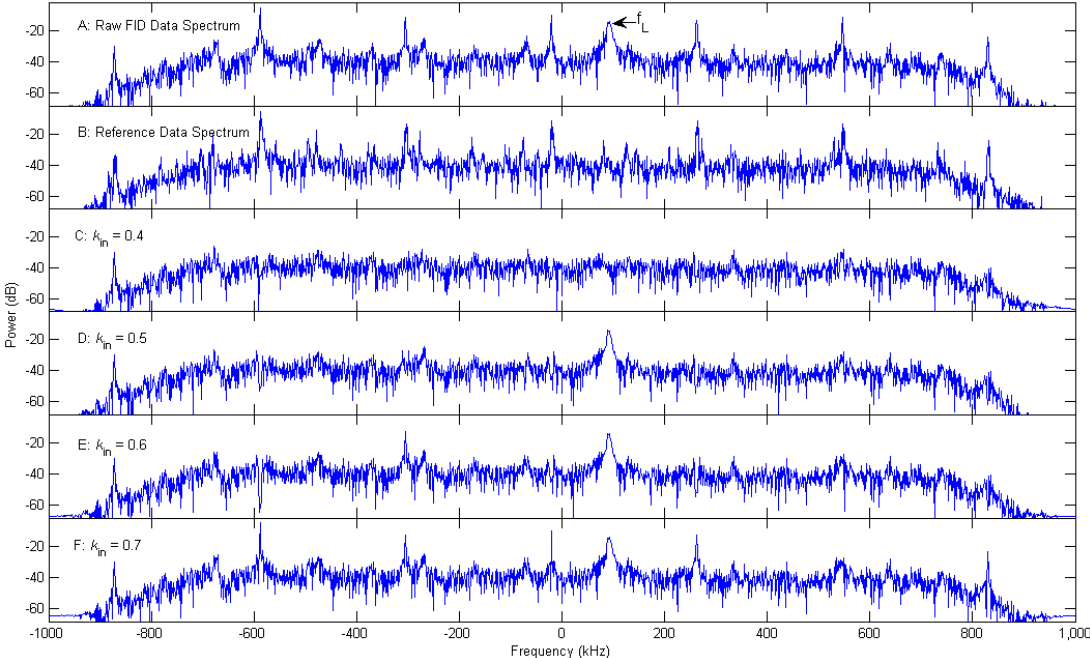
Figure 6. Fourier amplitude spectra of ( A ) the FID data; ( B ) the corresponding reference data; and various spectra after interference cancellation with different threshold value ( C ) k in = 0.4; ( D ) k in = 0.5; ( E ) k in = 0.6; ( F ) k in = 0.7,